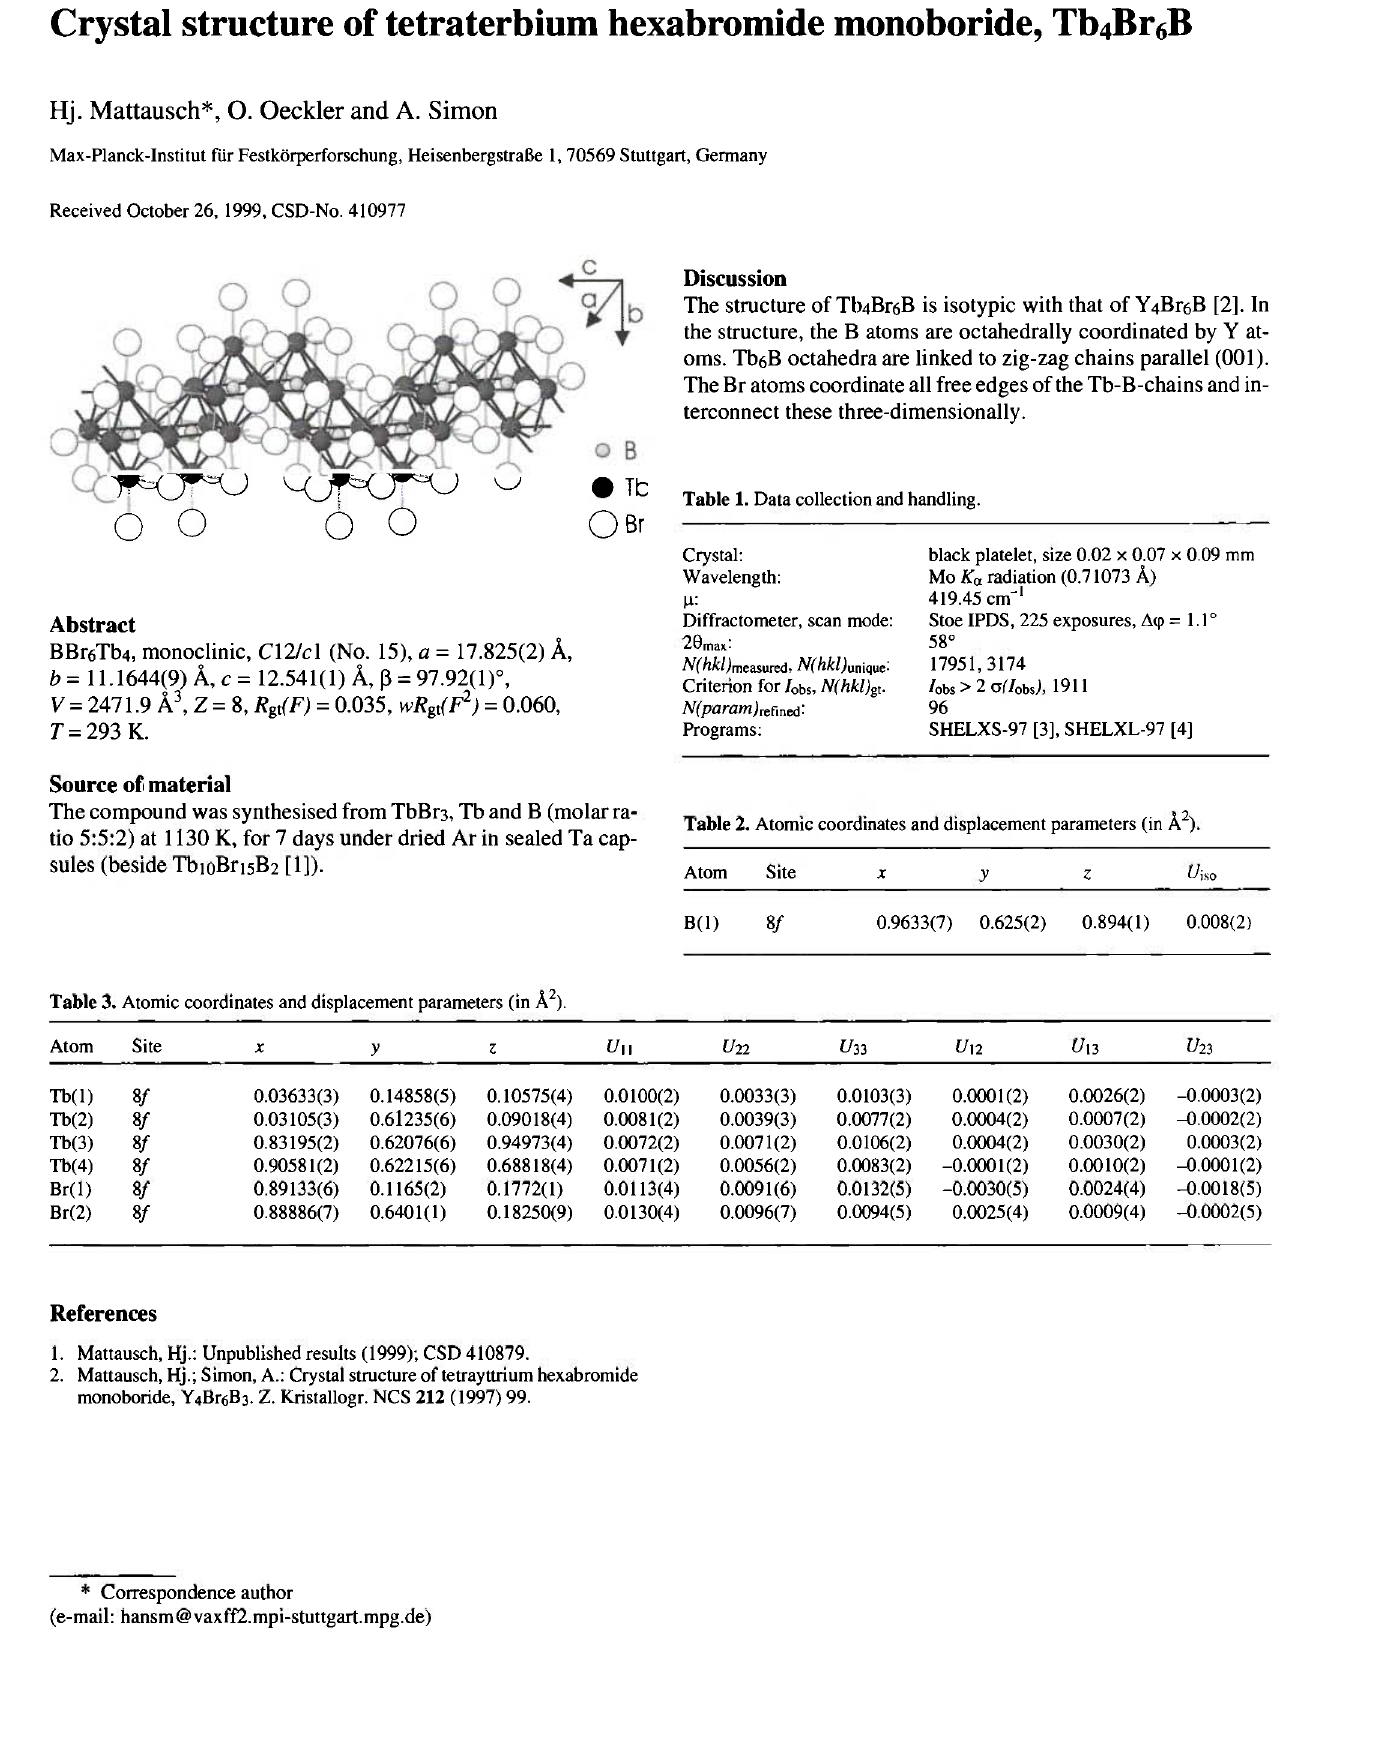
Table 3. Atomic coordinates and displacement parameters (in Ä 2